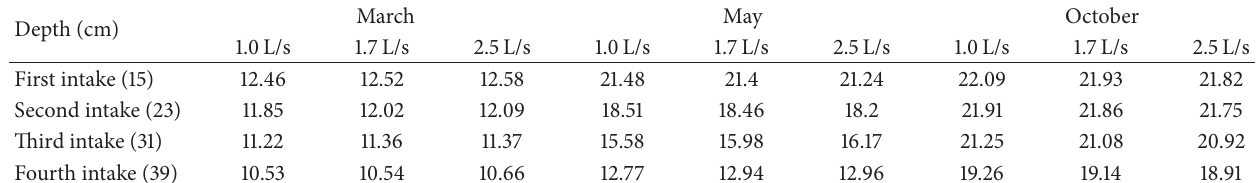
Table 1: Withdrawn water temperature with different submerse depths and discharges.